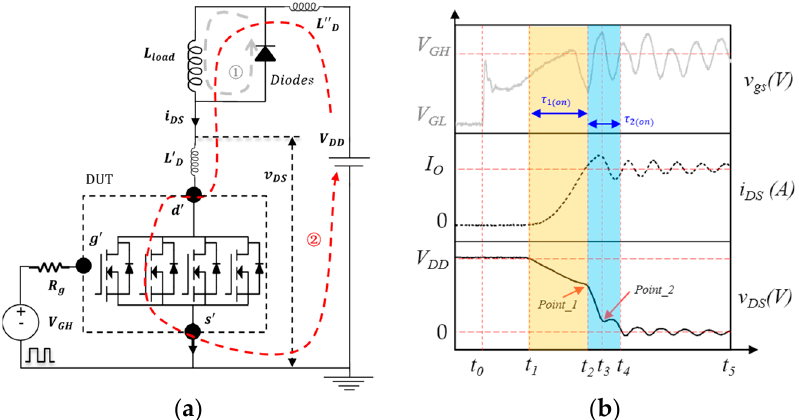
Figure 4. Typical diagrams for turn-on transient analysis for SiC high-power module in DPT: ( a ) commutation paths of the current flow, ( b ) turn-on transient process.